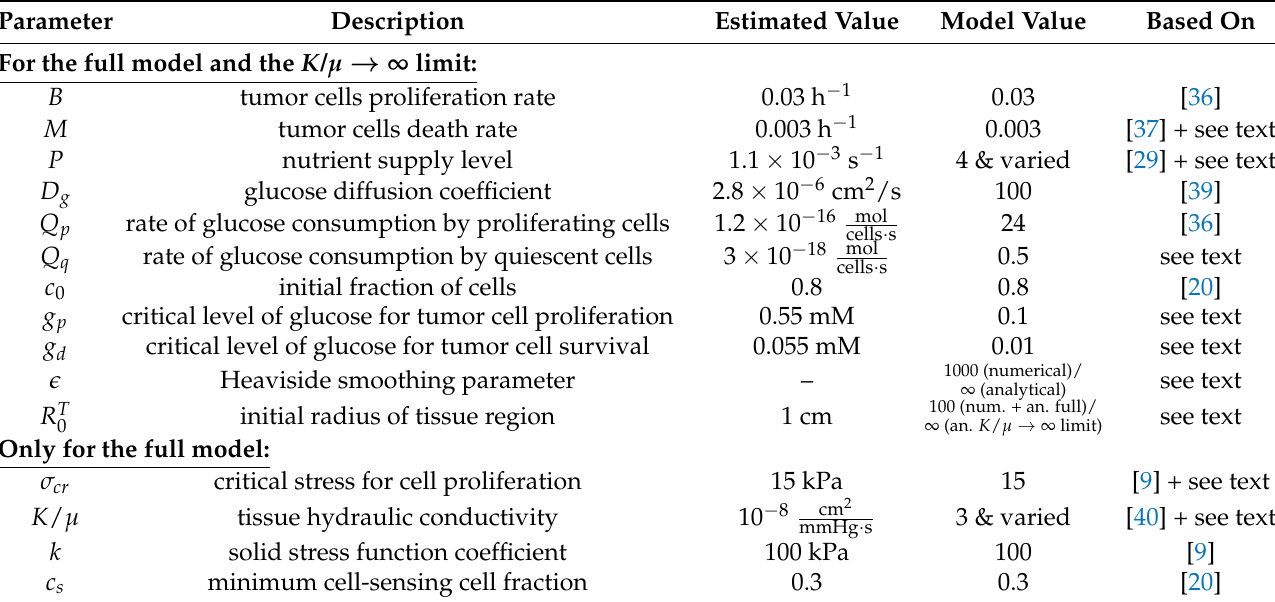
Table 1. Basic set of model